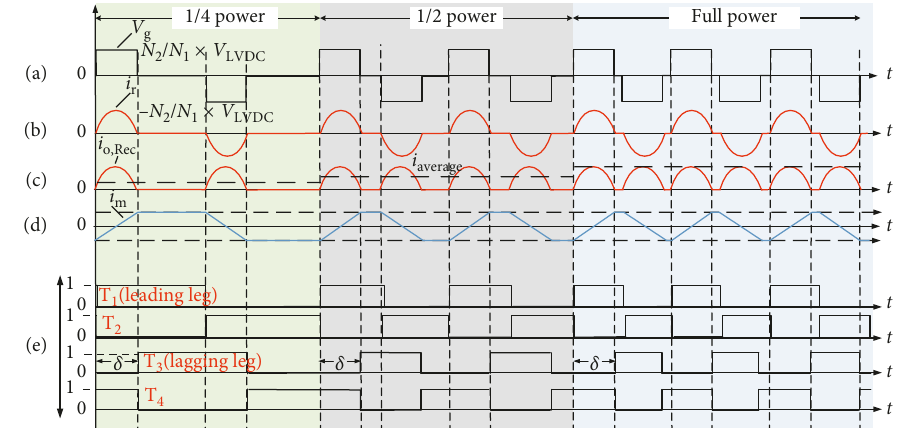
Figure 4: Operation waveform of SRC#: (a) inverter output voltage V output averaged current i